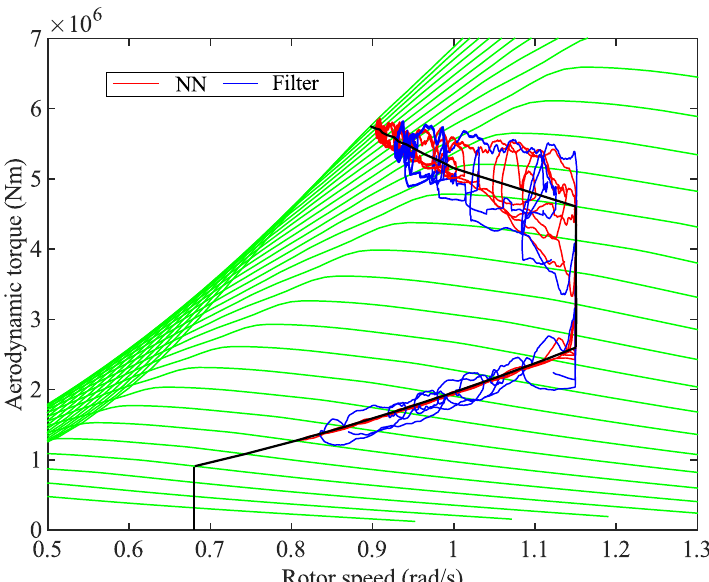
Figure 16. Control operation results in torque-speed plane; refer to Figure 3 for the green wind speed